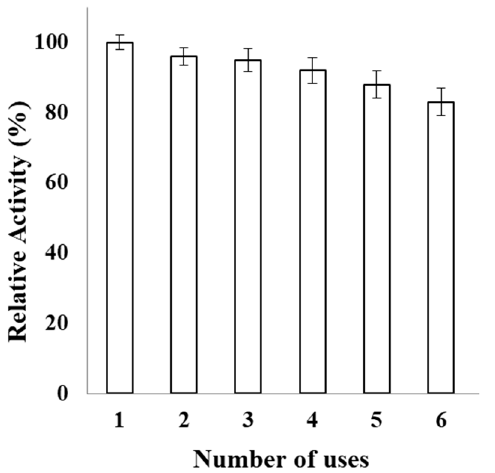
Figure 8. Reusability of immobilized β -galactosidase. Reusability of immobilized β -galactosidase (100 µ L) was monitored for 6 successive days. The aliquots were taken in triplicates and were assayed for the remaining percent activity. The activity determined on the first day was taken as control (100%) for the calculation of remaining activity after each